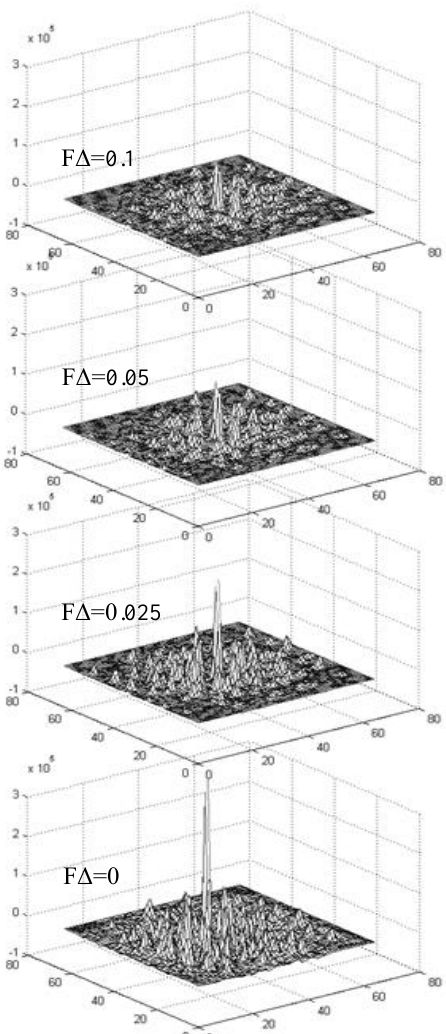
Fig.1. Correlation between seeding particle density (MI) and signal peak ratio.